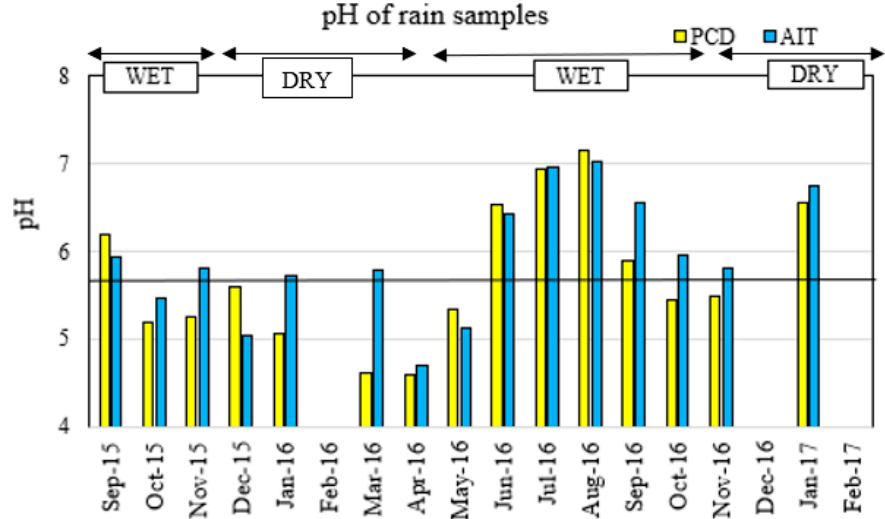
Figure 4. Monthly variations of pH at PCD and AIT sites from September 2015 to February 2017. (Blank data denote no precipitation samples could be collected due to insufficient rainfall.) Source: Mettasitthikorn, 2017 (see text).